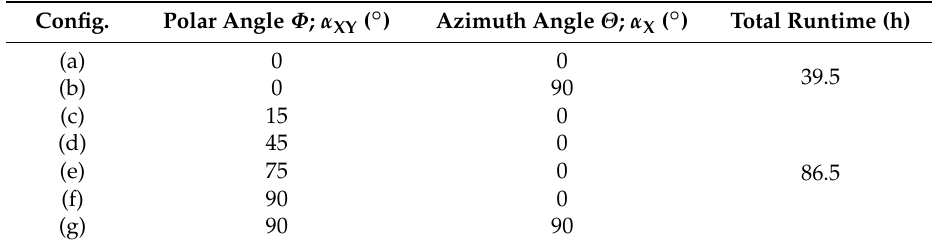
Table 2. Summary of positioning details for all considered configurations, grouping of individual manufacturing jobs and corresponding time per job.